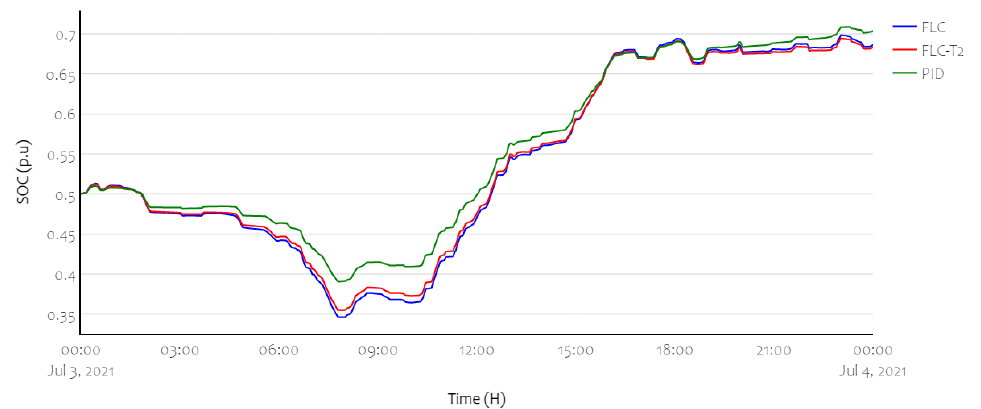
Figure 7. Comparison of BESS state-of-charge with the EFR controller on a weekend day managed by conventional FLC ( blue ), PID controller ( green ), and Type-2 FLC ( red